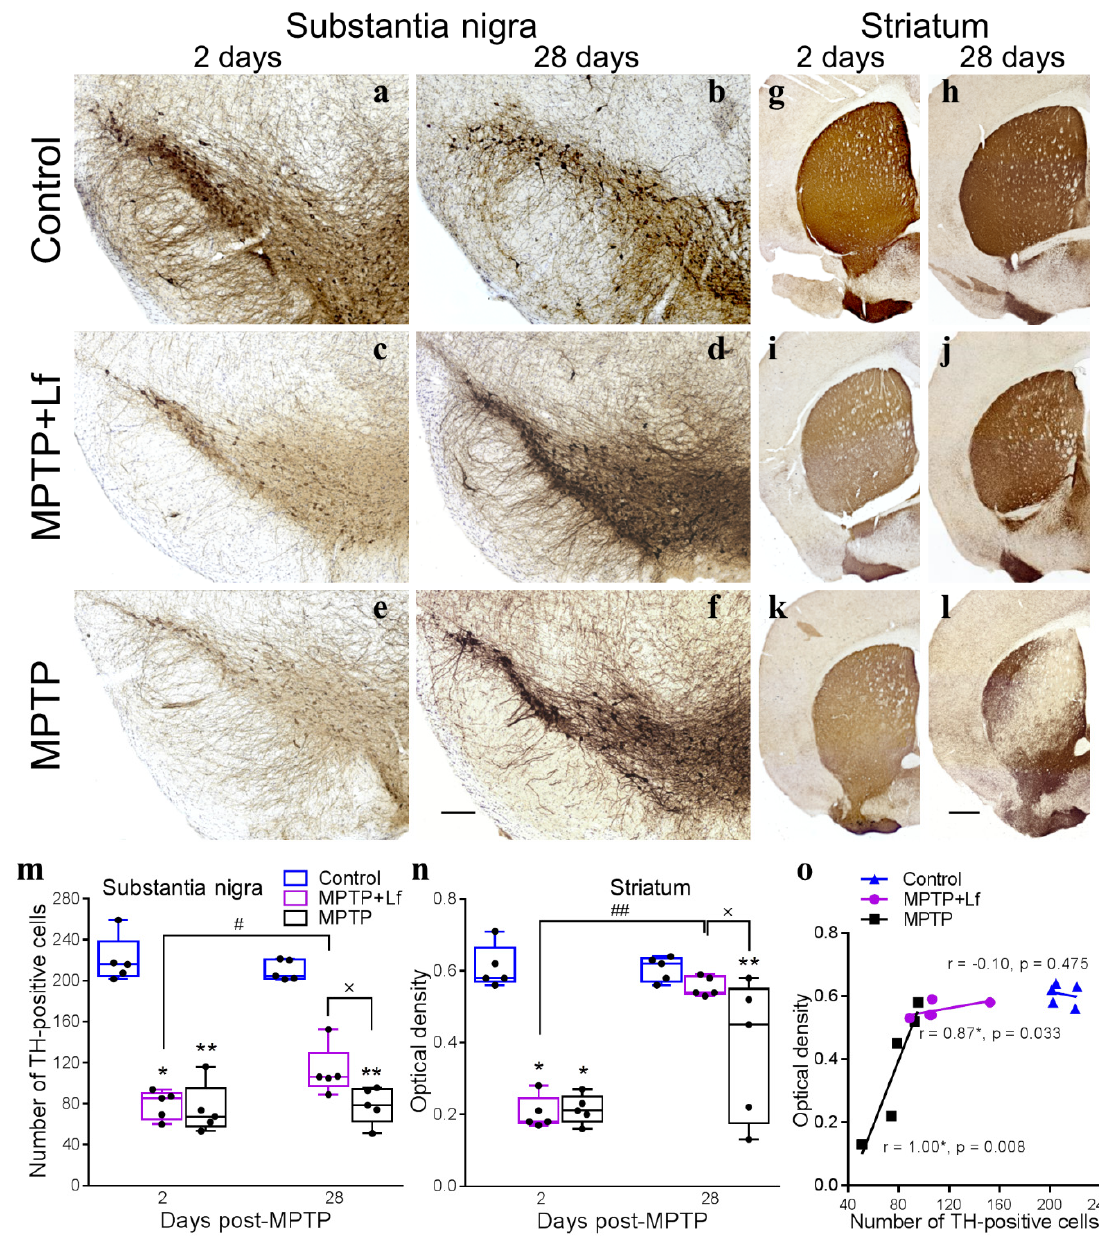
Figure 6. Effects of Lf on MPTP-induced neurodegeneration. Representative photomicrographs of SNpc ( a – f ) and striatum ( g – l ) sections immunostained for TH. Number of TH-positive neurons in SNpc; n = 5–7 representative sections from each mouse ( m ). Each dot represents a single animal. Striatal TH-positive optical density; n = 5 sections from each mouse ( n ). Correlation between the SNpc TH-positive neuronal counts and the striatal TH-positive optical density on day 28 ( o ). Scale bars = 200 µm ( a – f ), 500 µm ( g – l ). * p < 0.05, ** p < 0.01 compared to the Control group (saline-treated) at an each time point (Kruskal–Wallis ANOVA followed by post hoc Dunn’s multiple comparisons test); # p < 0.05, ## p < 0.01 compared to the same group at the previous time point; x p < 0.05 (Mann–Whitney U test).